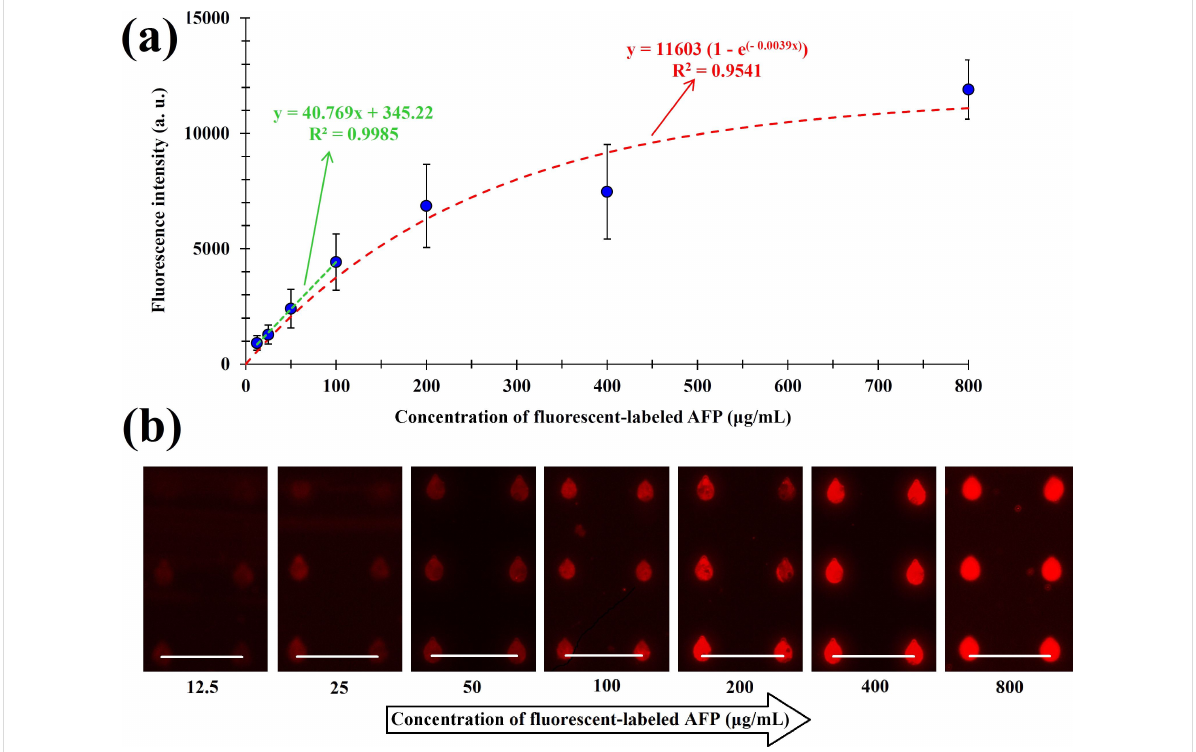
Figure 5: Evaluation of the sensitivity of the microarrays prepared from the sample of route 5 after incubating anti-AFP spots with fluorescently labeled AFP. a) Fluorescence intensity of the microarrays at different concentrations of fluorescently labeled AFP (12.5, 25, 50, 100, 200, 400 and 800 μ g/mL). b) Fluorescence microscope images of the micropatterns. All microarrays were spotted at a relative humidity of 20%. The dwell and exposure times of all images were 0.1 and 0.4 s, respectively. As incubation conditions we chose 37 °C and 20 min. All scale bars are equal to 50 μ